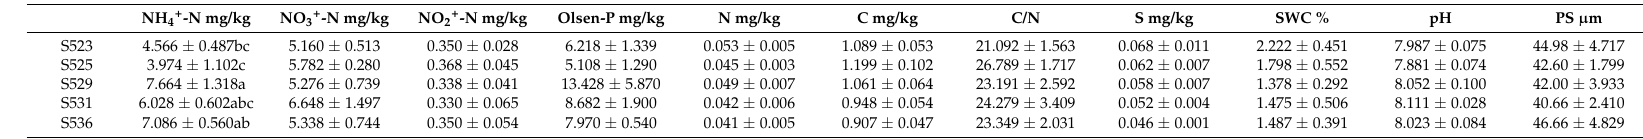
Table 1. Soil chemical properties of the different sub-dams (Mean ± Standard error). Significant differences between sites (Duncan test, p < 0.05) are denoted with letters (a > b > c).